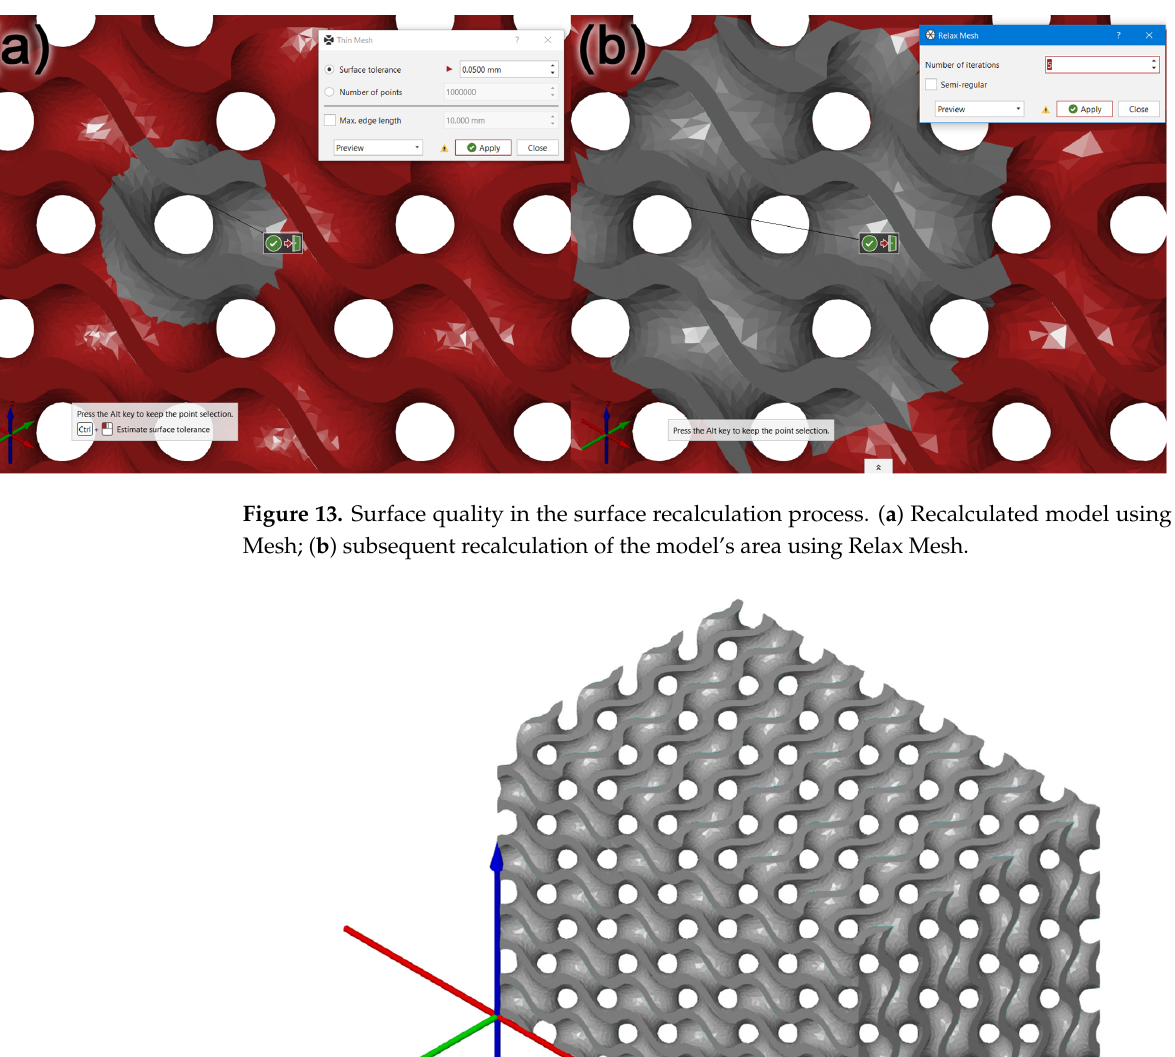
Figure 15. Recalculated cellular structure model. ( a ) Model in Cura, ( b ) illustration of the toolpath process of manufacture with FDM technology, and ( c ) illustration of the toolpath in the model’s inner layer. 4. Conclusions Through the comparison and visual inspection of the models, it was found that the models with Very Low and Low accuracy had low-quality surfaces and low fidelity to a like-ideal geometric model of the structure, which is why they are not suitable for physical model production. The Medium model at the same σ had a lower Deviation Range and lower STL file size than the High accuracy model. A visual inspection found that when